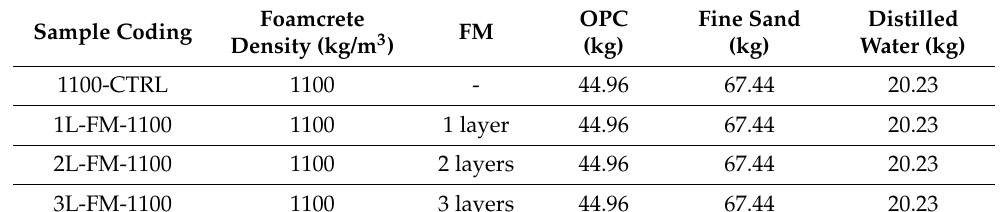
Table 2. Foamcrete mix design.